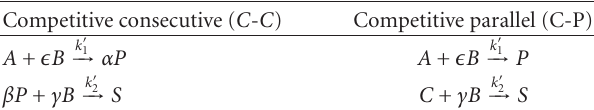
Table 1: General mixing sensitive reaction